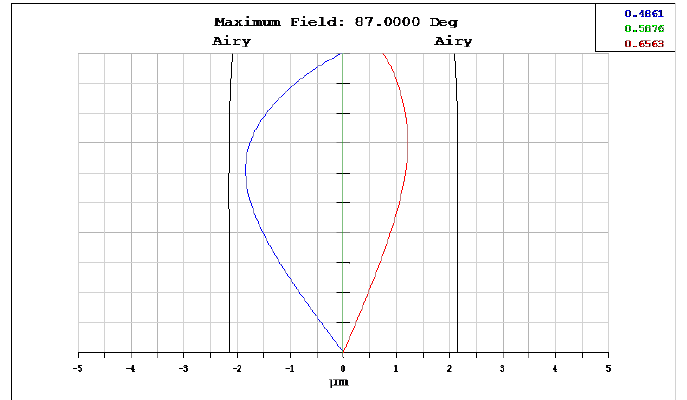
Figure 5. Field curvature ( left ) and distortion plot ( right ) of a miniaturized wide-angle fisheye lens using an OKP4HT aspherical lens.